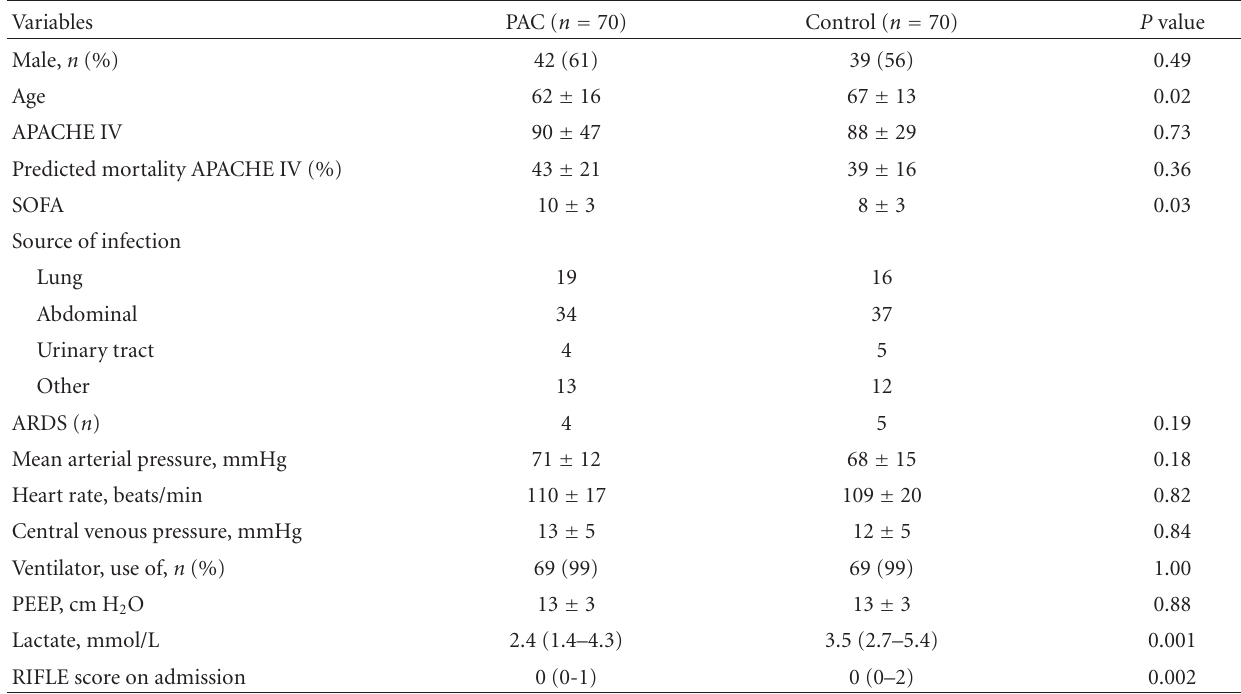
Table 1: Baseline characteristics.